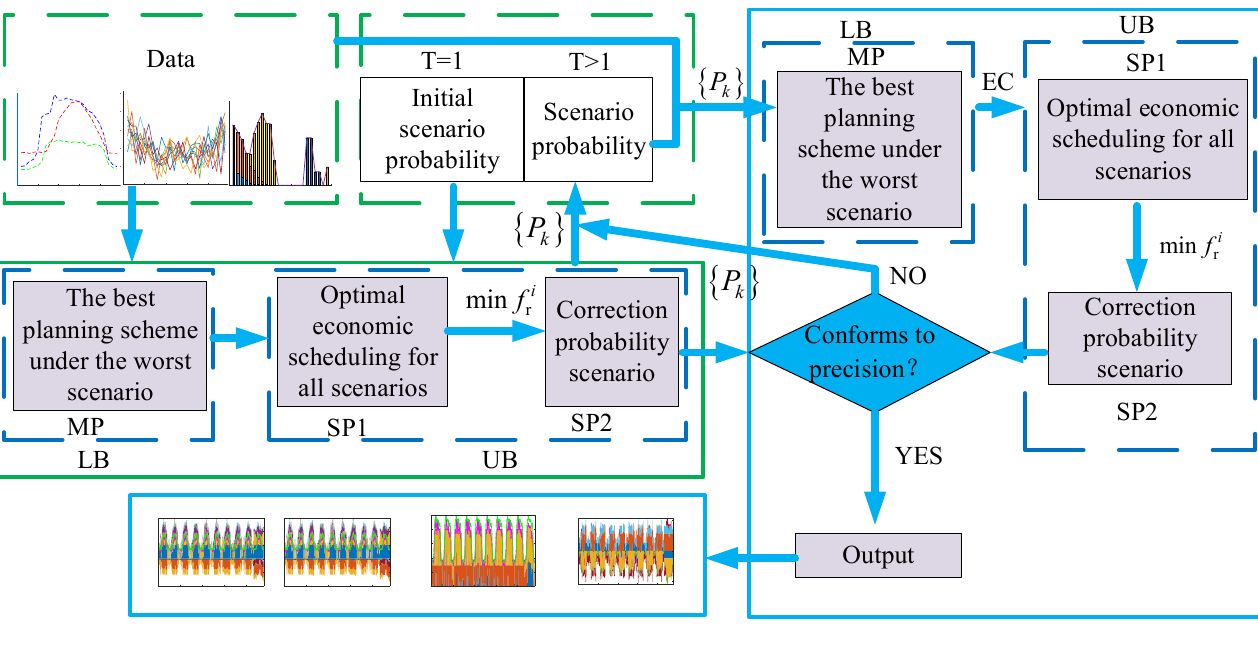
Figure 3. Flow chart of the model optimization process.